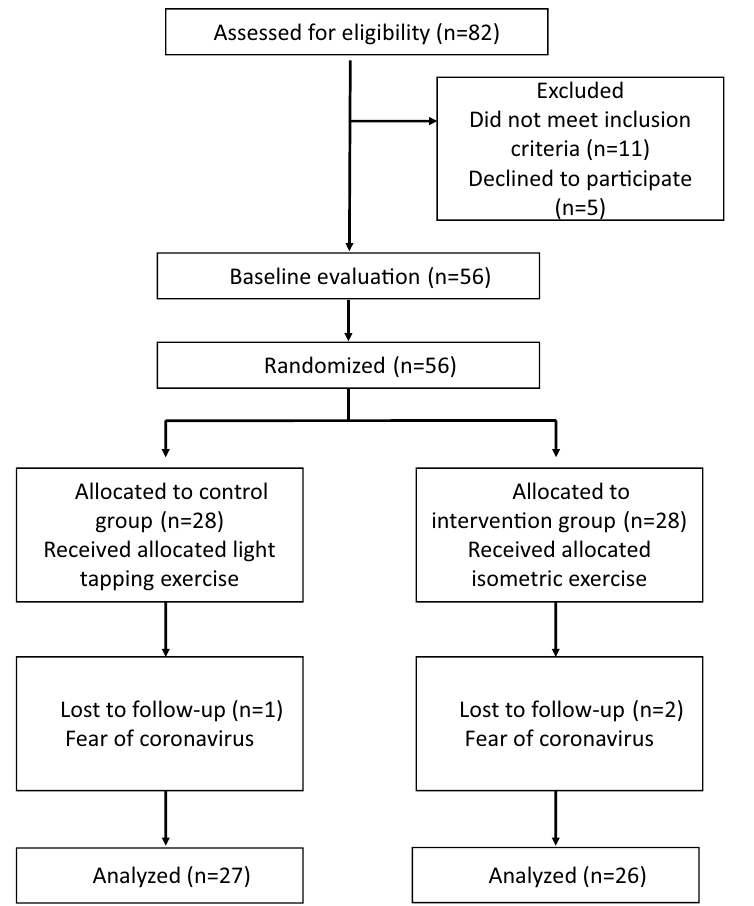
Figure 1. Flow diagram of this randomized-controlled